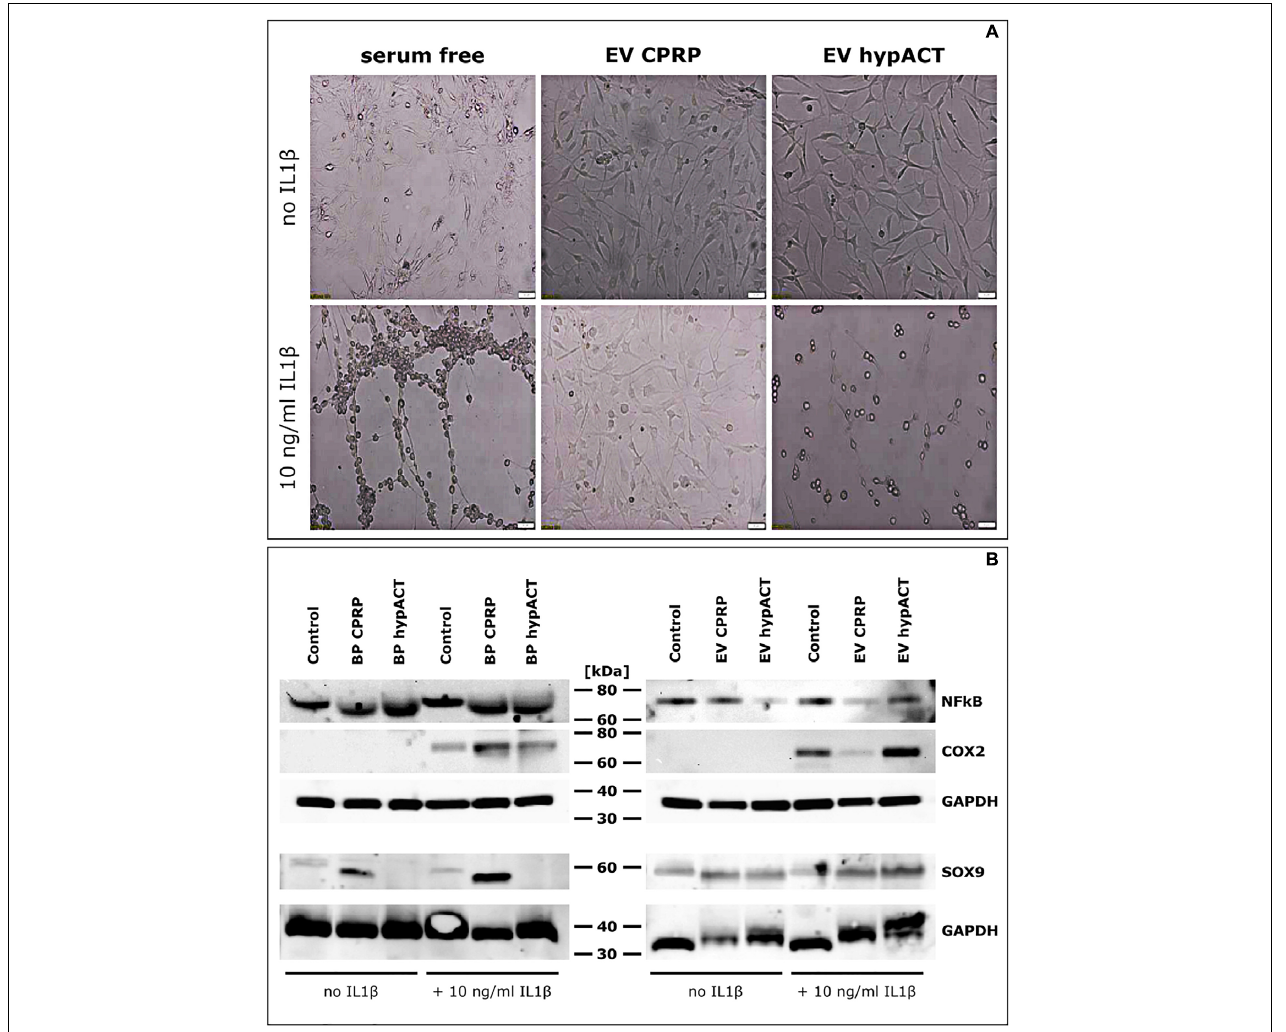
FIGURE 6 | Impact of EVs on pro-inflammatory signaling in OA chondrocytes. (A) Morphological changes mediated by EVs from CPRP or hypACT in absence or presence of IL1 β . Scale bars 100 µ m. (B) Protein expression of NF- κ B and COX2 in chondrocytes treated with blood products or EVs in absence or presence of IL1 β compared to untreated cells assessed via Western Blot. (C) Quantification of interleukin 6 (IL6) in cell culture supernatants after 48 h via ELISA. Statistical significance was determined via one-way ANOVA and Tukey’s post hoc test with α = 0.05. Data are given as arithmetic mean ± SD of duplicate measurements of three independent chondrocyte donors. Medium controls were mesured in duplicate, both values are given, as the same medium was used for each donor. BP, blood product; **** p < 0.0001; n.s, not significant.